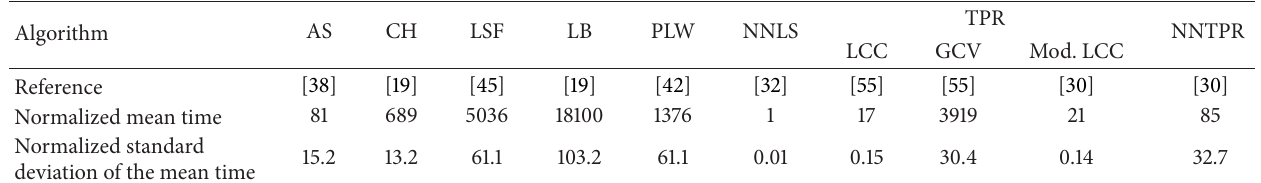
Table 2: Comparison of the normalized computational demand of the applied numerical inversion techniques; CH, LB, and PLW have fixed iteration number.